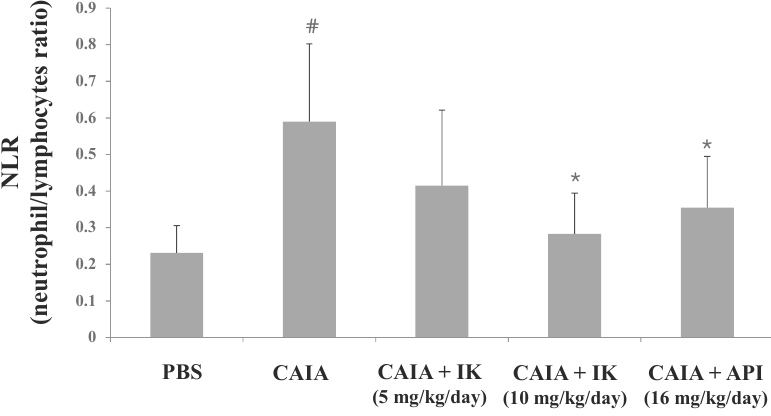
Figure 6. Effect of IK and API on neutrophil-to-lymphocyte ratio in CAIA mice. Whole blood samples were collected by cardiac puncture. Data are presented as means ± SD ( n = 6). # p < 0.05 vs. normal-group and * p < 0.05 vs. CAIA-group.